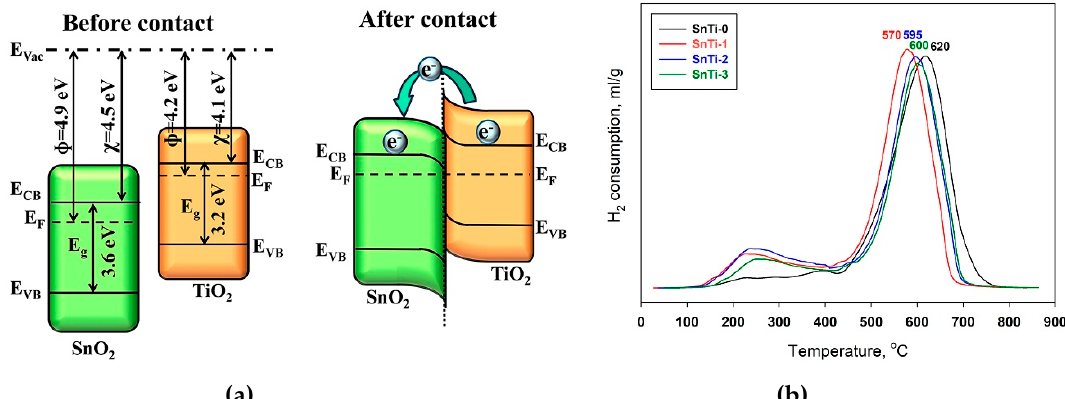
Figure 11. ( a ) Estimated band alignment of the SnO 2 (cassiterite) and TiO 2 (anatase) phases (left) and SnO 2 / TiO 2 n - n heterocontact (right); ( b ) TPR-H 2 profiles of unmodified SnO 2 (SnTi-0) and TiO 2 @SnO 2 nanocomposites.